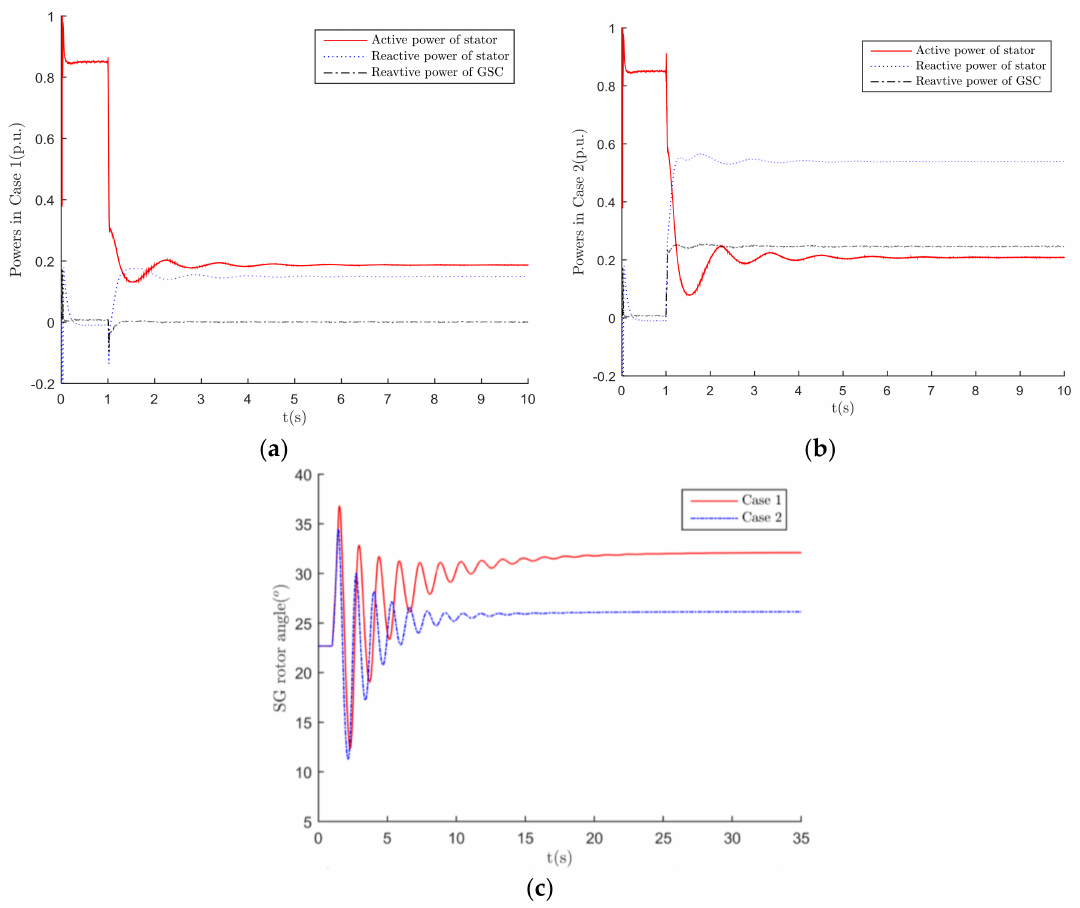
Figure 7. Simulation results of Cases 1 and 2 ( a ) power curves of DFIG in Case 1; ( b ) power curves of DFIG in Case 2; and, ( c ) rotor angle curves of SG in Cases 1 and